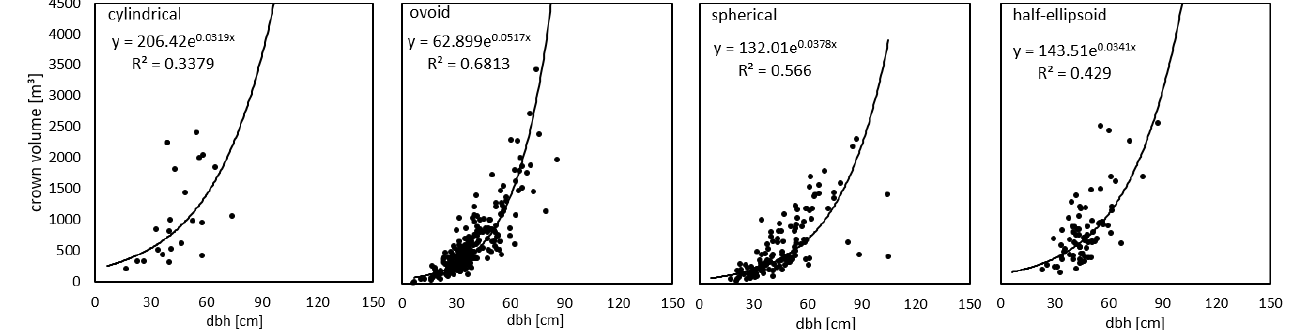
Figure 6. Relationship of crown volume and dbh for the four different crown shapes. Graphs show all 258 trees. The mathematical constant e in the equations indicates the Euler’s number.